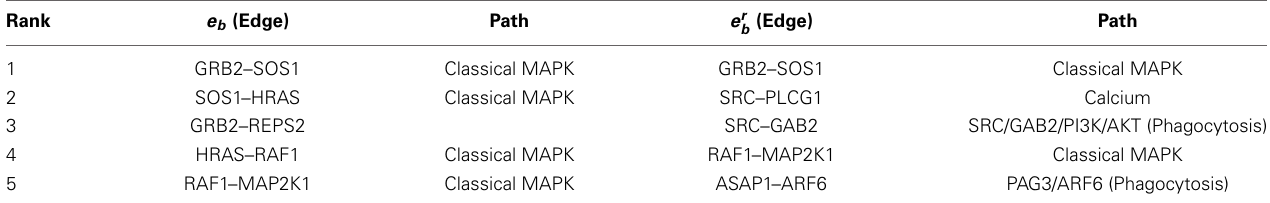
Table 5 | High betweenness edges in EGFR pathway.